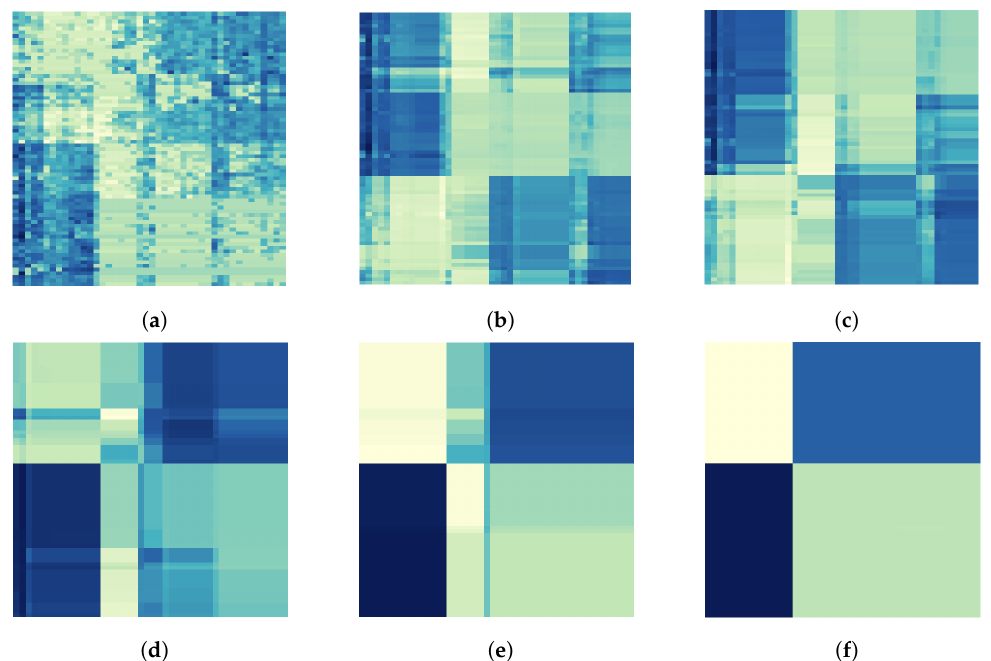
Figure 4. The heatmap results of proposed method implementation on the presidential speeches dataset under a wide range of λ . ( a ) λ = 0; ( b ) λ = 1500; ( c ) λ = 2000; ( d ) λ = 5000; ( e ) λ = 15,000; ( f ) λ = 30,000.